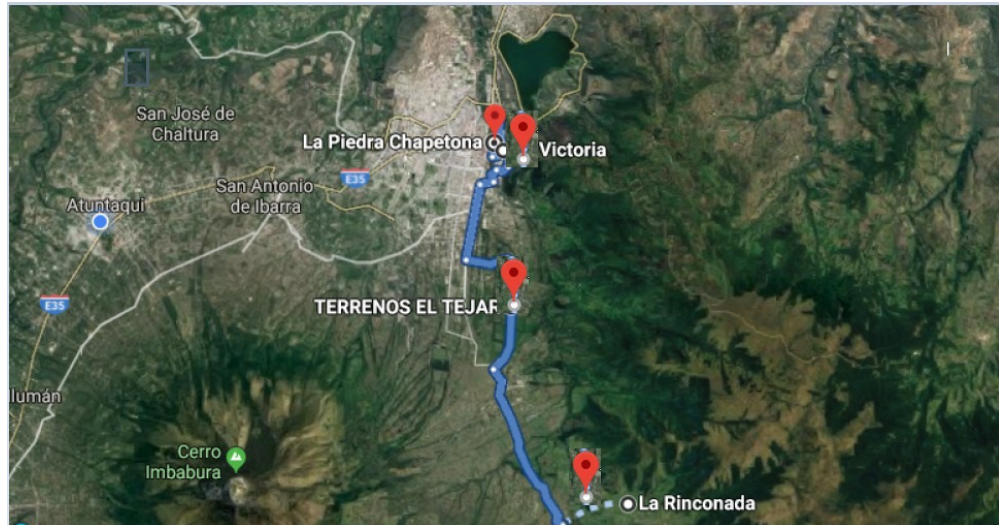
Figure 3. Geographic location of the WSN nodes. Spots strategically selected to acquire data from, in order to encompass representative zones, as well as different types and levels of river